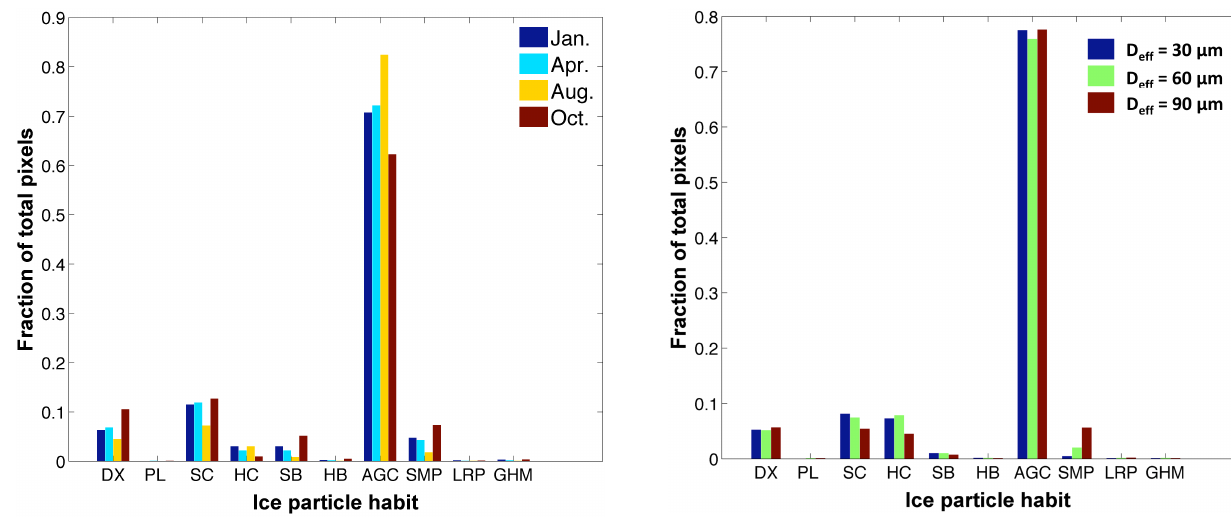
Fig. 5. Ice habit inferred for three effective diameters from global data recorded on 1 August 2007. The histogram provides the frac- tion of total pixels assigned as one of the 9 single habits or general habit mixture defined in Fig. 1